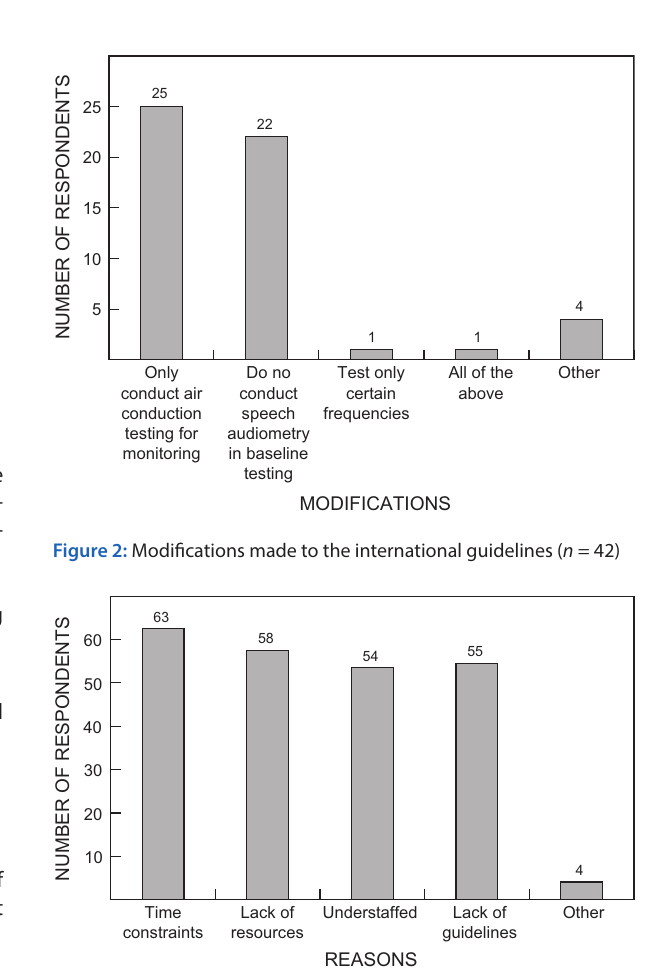
Figure 3: Reasons for modifications to the international guidelines